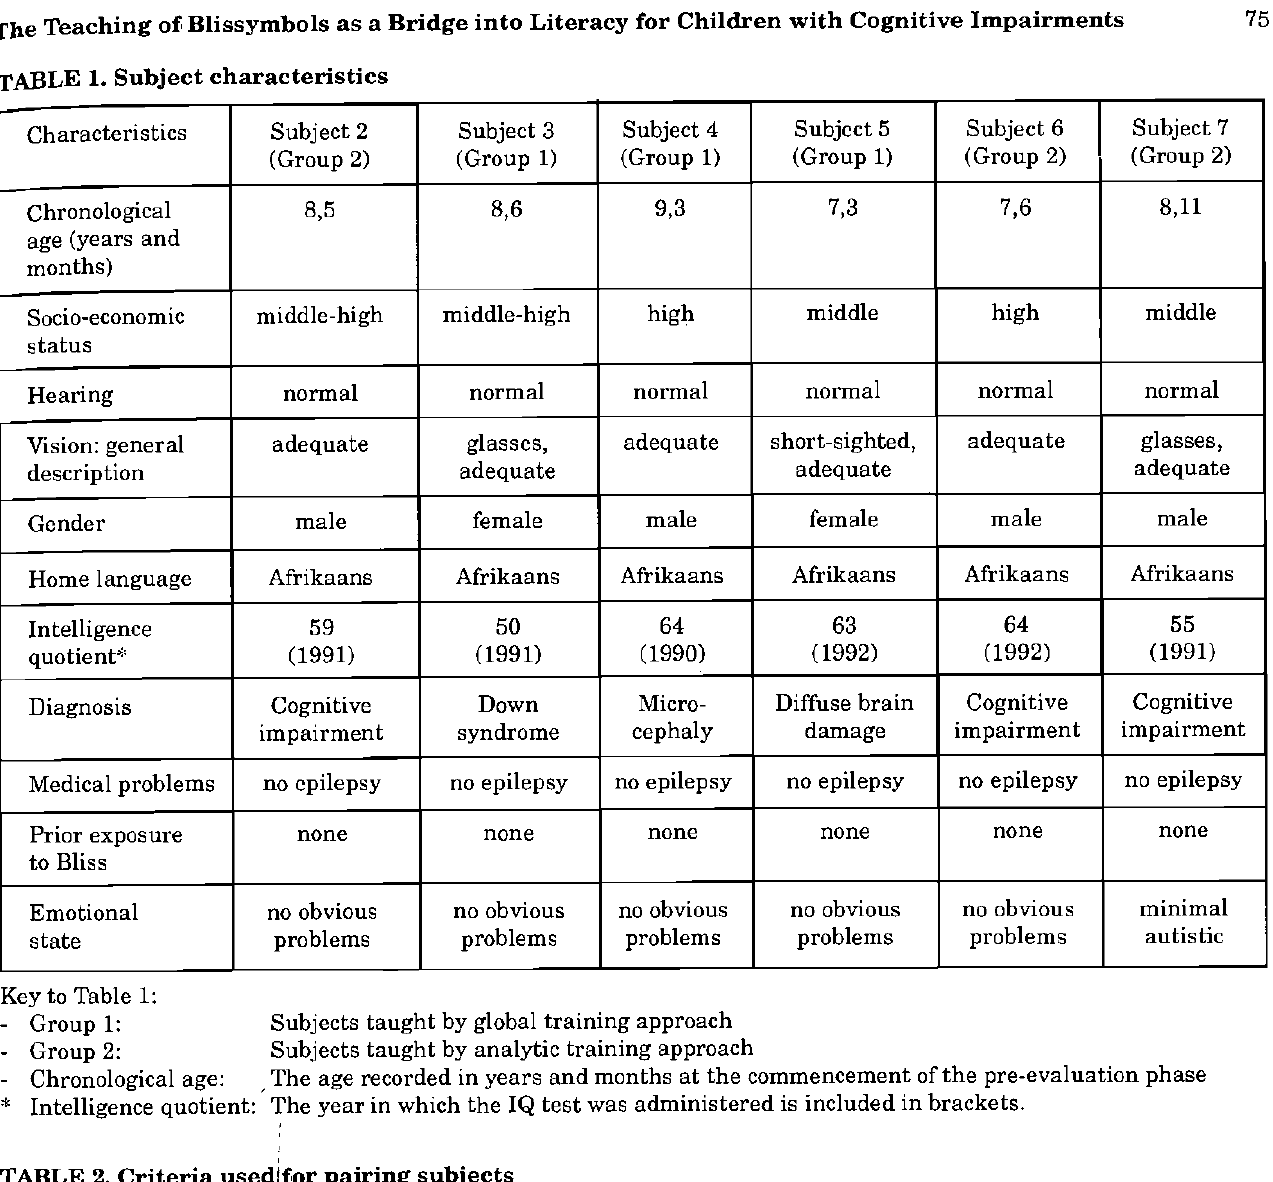
TABLE 2. Criteria used for pairing subjects